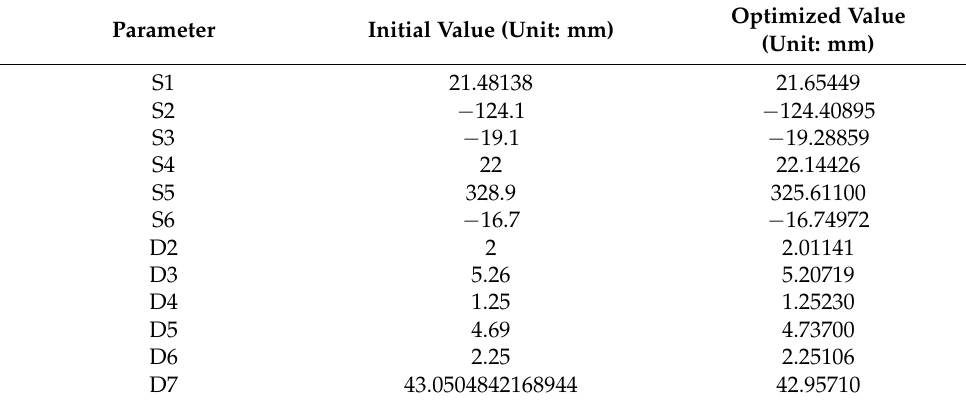
Table 5. Comparison of design parameters before and after optimization (Case 1).